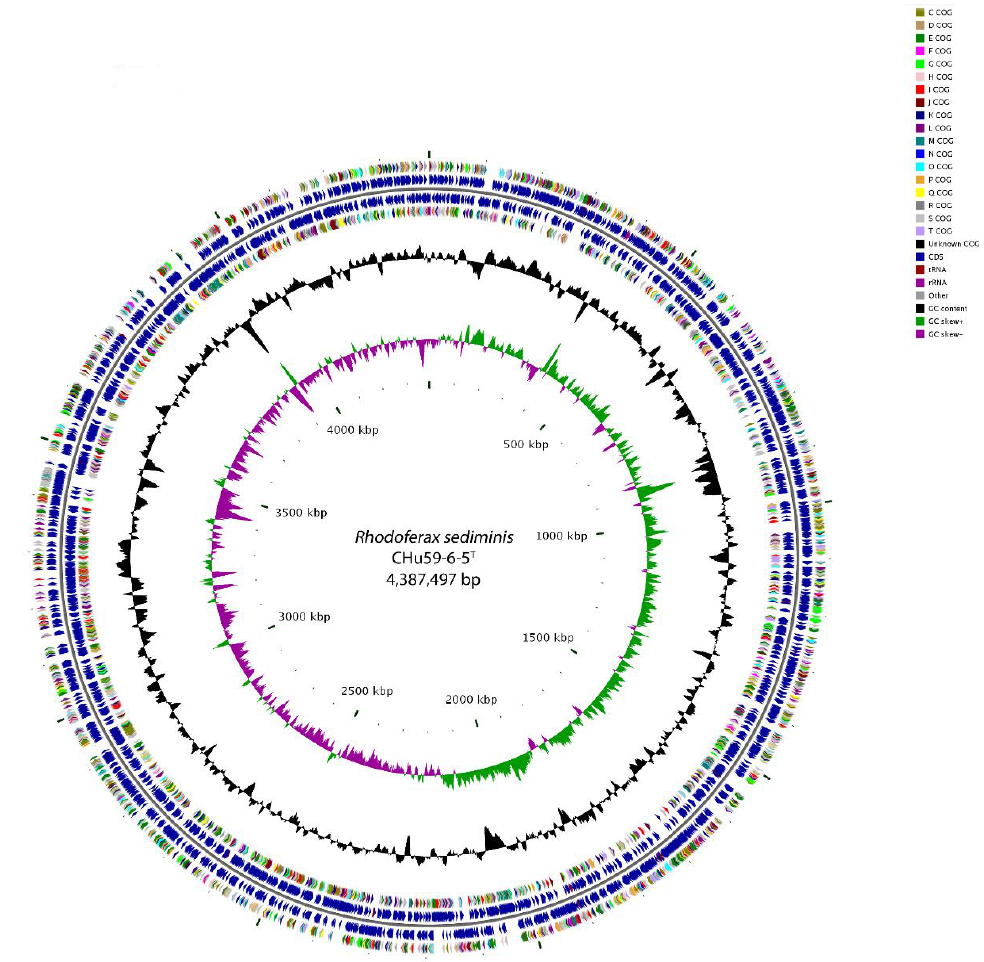
Figure 3. Graphic representation of circular genome plot of CHu59-6-5 T . From the inner to the outer circle: The circles represent from outside to inside with the first and last circle showing the genomic position. The second and fifth circle shows the predicted protein coding sequences according to the COG (Clusters of Orthologous Group) database. The third and fourth circle shows protein-coding regions. The sixth circle represents variation in G + C content. The seventh circle shows a GC skew ([G − C]/[G + C]) plot of the genome.